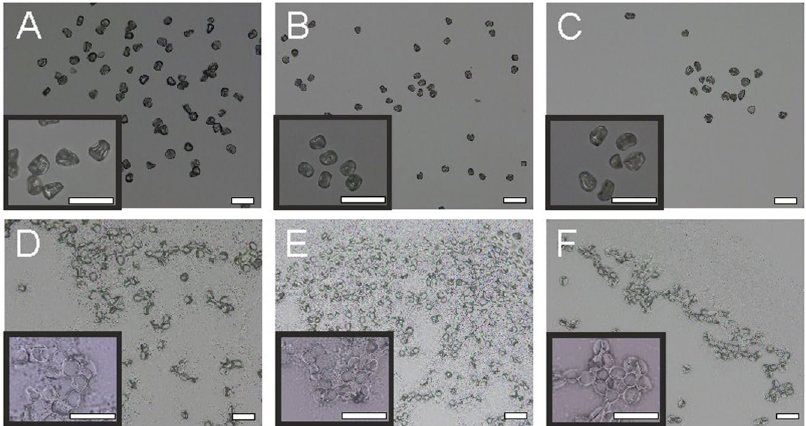
Figure 2. Bright field images of the three different pollen species A. odoratum ( A , D ) , F. ovina ( B , E ) and P. alpina ( C , F ) before ( A – C ) and after adding formic acid ( D – F ). Images were taken with two different magnifications. Scale bar = 50 µ